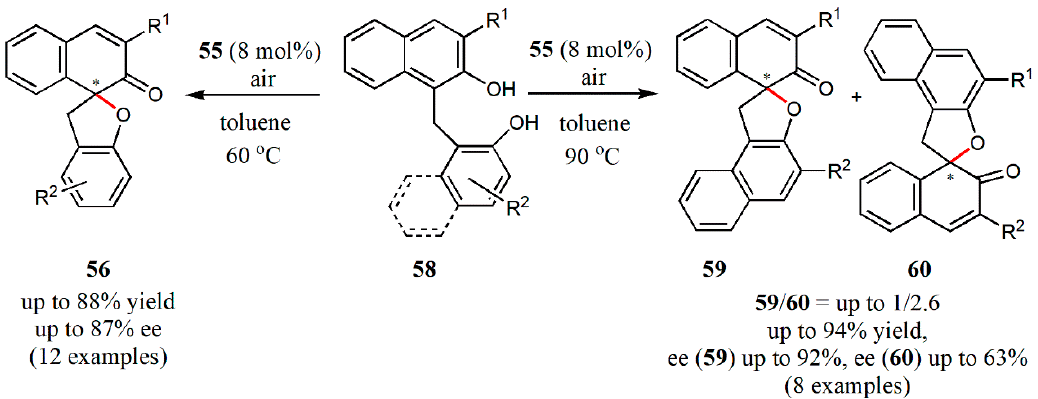
Figure 18. Oxidative spirocyclization of methylenebis(arenol) derivatives.